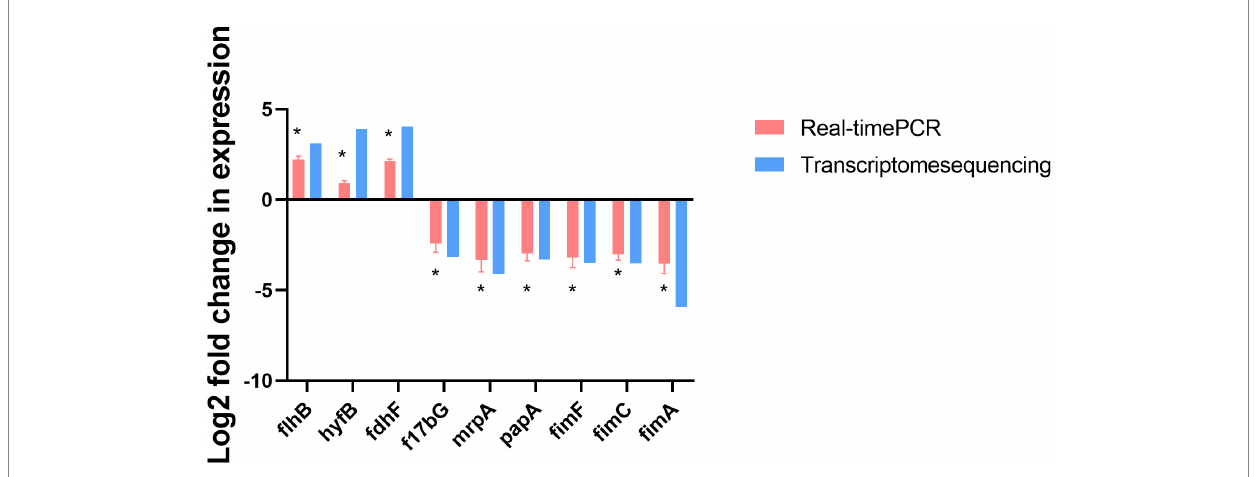
FIGURE 9 RT-qPCR confirmation of the three upregulated and six downregulated genes in Δ modA relative to DP2019. Values are the means of at least three independent assays. Error bars indicate standard deviations, * p <